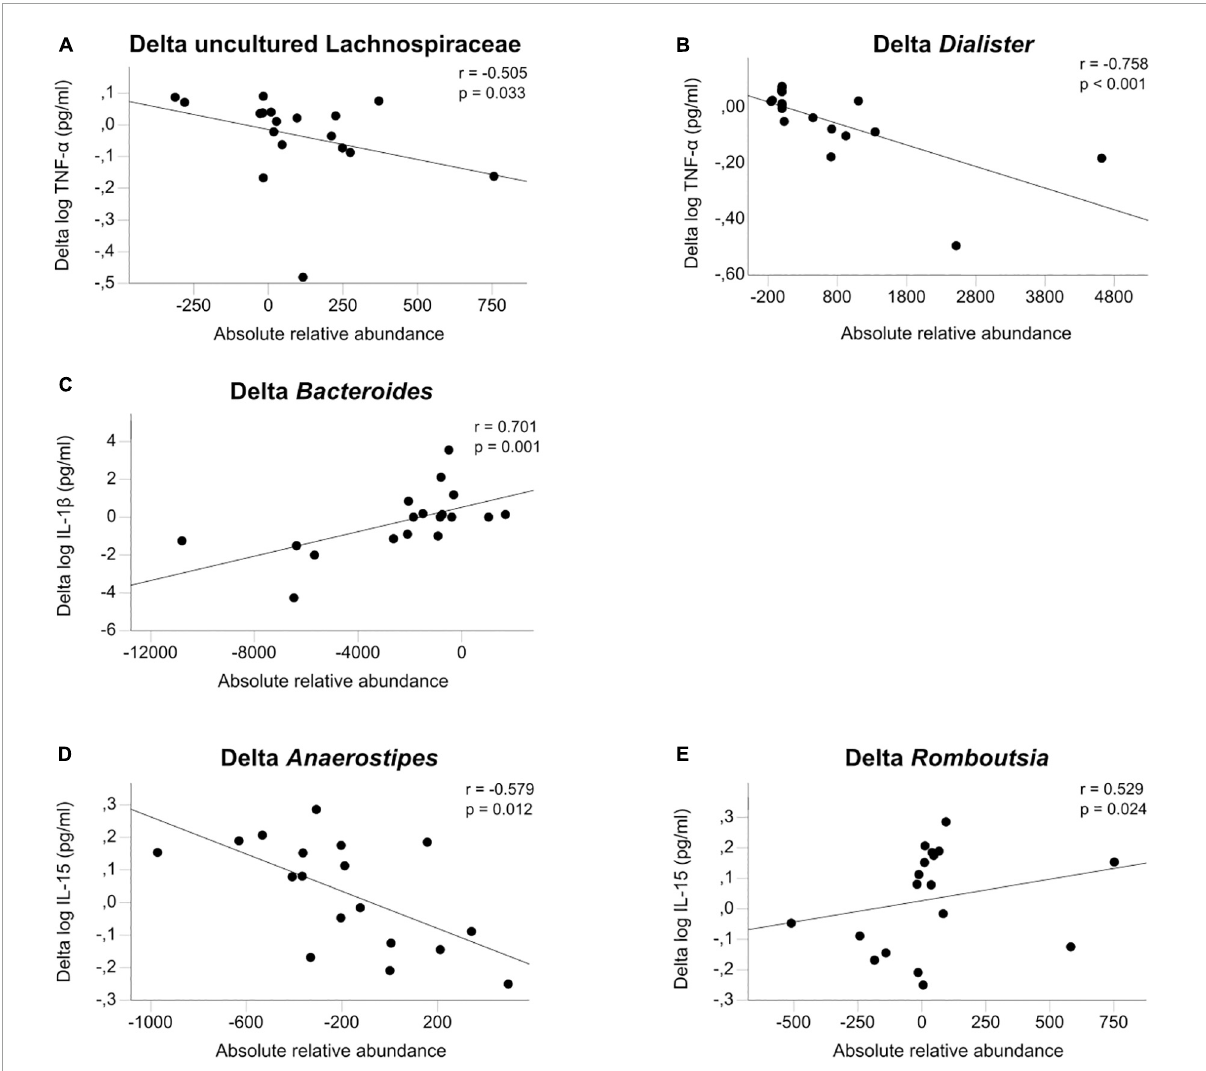
FIGURE3 (A–E) Microbiome associations. Associations of the change between admission and discharge of log transformed cytokines TNF- α , IL-1 β , and IL-15 with the change in gut microbiota calculated with Spearman’s general correlation coefficient. The total normalized number of reads was 17,500